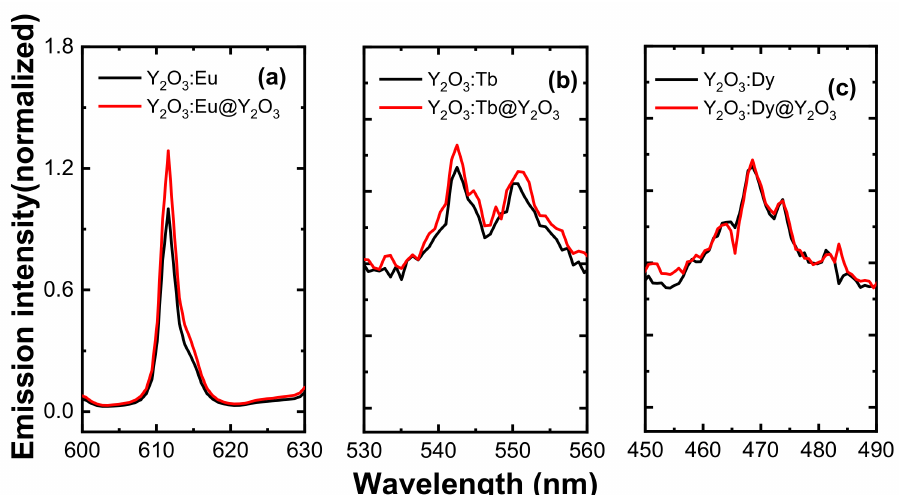
Figure 7. Relative luminescence spectra of the RE-doped Y 2 O 3 core and Y 2 O 3 passive shell- coated Y 2 O 3 :RE core. ( a ) Relative luminescence spectra of 0.10 mM of Eu 3+ -doped Y 2 O 3 core and Y 2 O 3 :Eu@Y 2 O 3 , ( b ) relative luminescence spectra of 0.05 mM of Tb 3+ -doped Y 2 O 3 core and Y 2 O 3 :Tb@Y 2 O 3 , ( c ) relative luminescence spectra of 0.05 mM of Dy 3+ -doped Y 2 O 3 core and Y 2 O 3 :Dy@ Y 2 O 3 . All the core samples were annealed at 550 ◦ C for 3 h and passive shells were annealed at 750 ◦ C for 3 h.